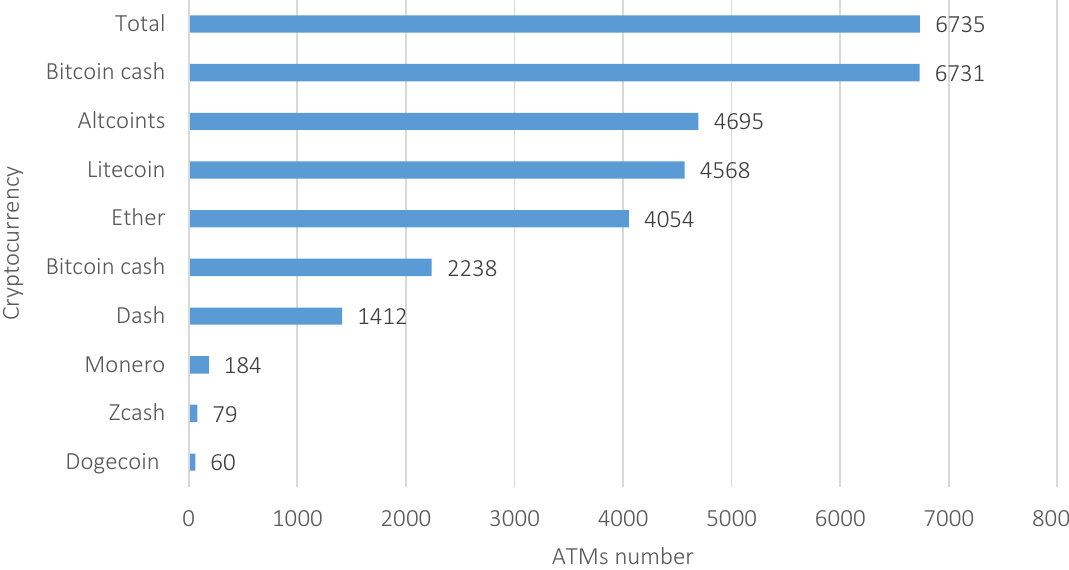
Figure 4. Crypto ATM supported cryptocurrencies